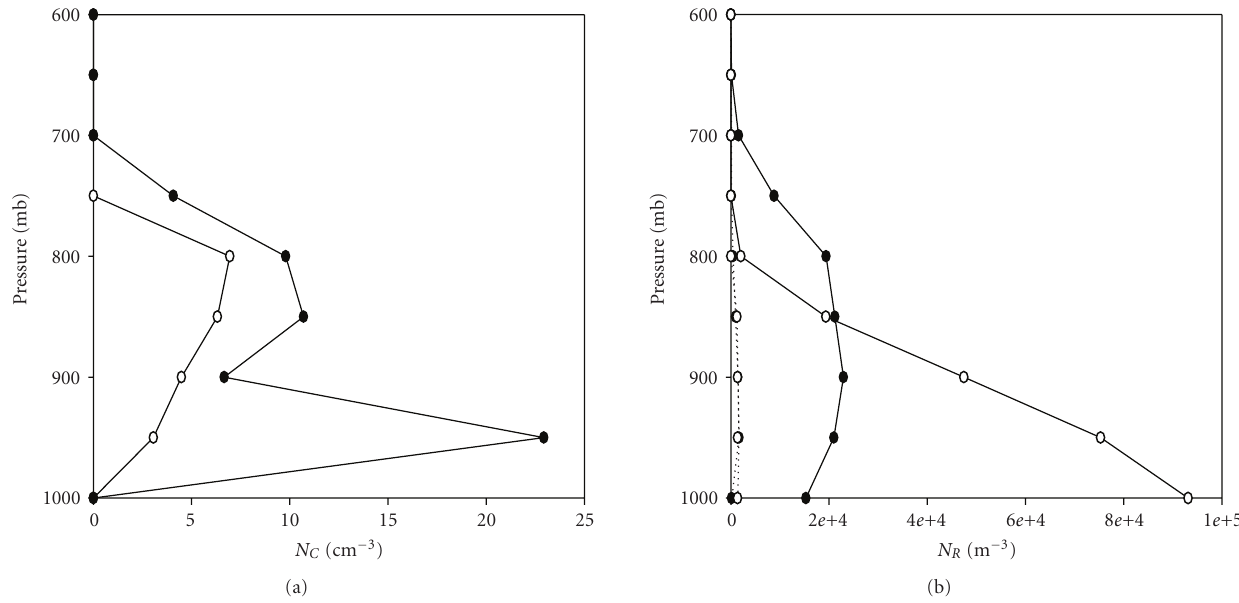
Figure 3: Modeled number concentrations of (a) cloud droplets and (b) raindrops over the regions “A” (closed circles) and “B” (open circles), as marked in Figure 2(a). The region “A” represents a relatively heavy rainfall region near the center of a cyclone, whereas a non- precipitating cloud region is observed in region “B.” The values are obtained from the cloud area averaged values during the six hours from 0600 UTC to 1200 UTC 24 February 2008. Solid lines indicate the results from the WDM6 scheme and dotted lines are from the WSM6 scheme. The number concentration for raindrops can be calculated using the slope of rain size distribution and intercept parameter of rain in the WSM6 microphysics scheme. A cloudy area is defined as either q C > 0 . 01g k g − 1 or q R > 0 . 01g k g − 1